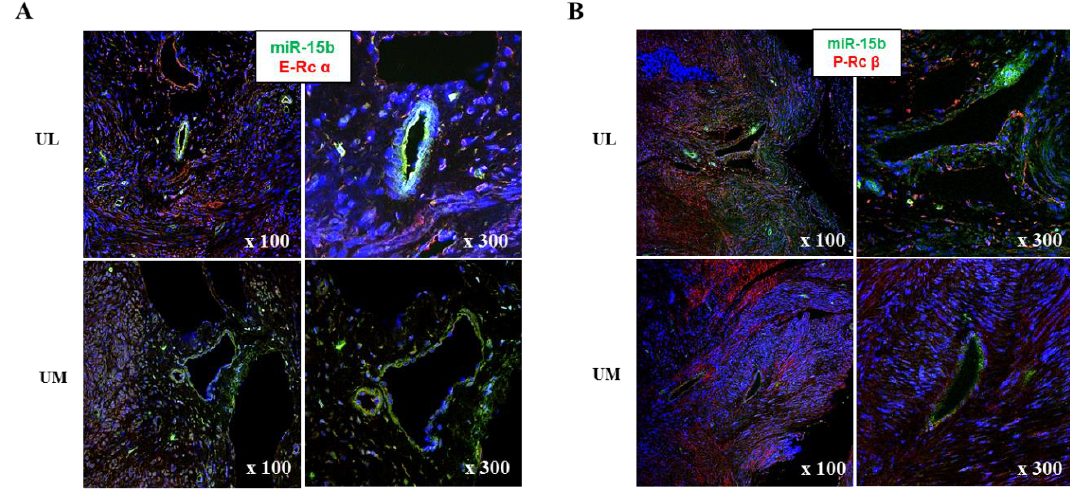
Figure 4. Analyses of target gene expression in myoma tissue. ( A ) Co-localization of miR-15b with estrogen receptor α. ( B ) Co-localization of miR-15b with progesterone receptor β.